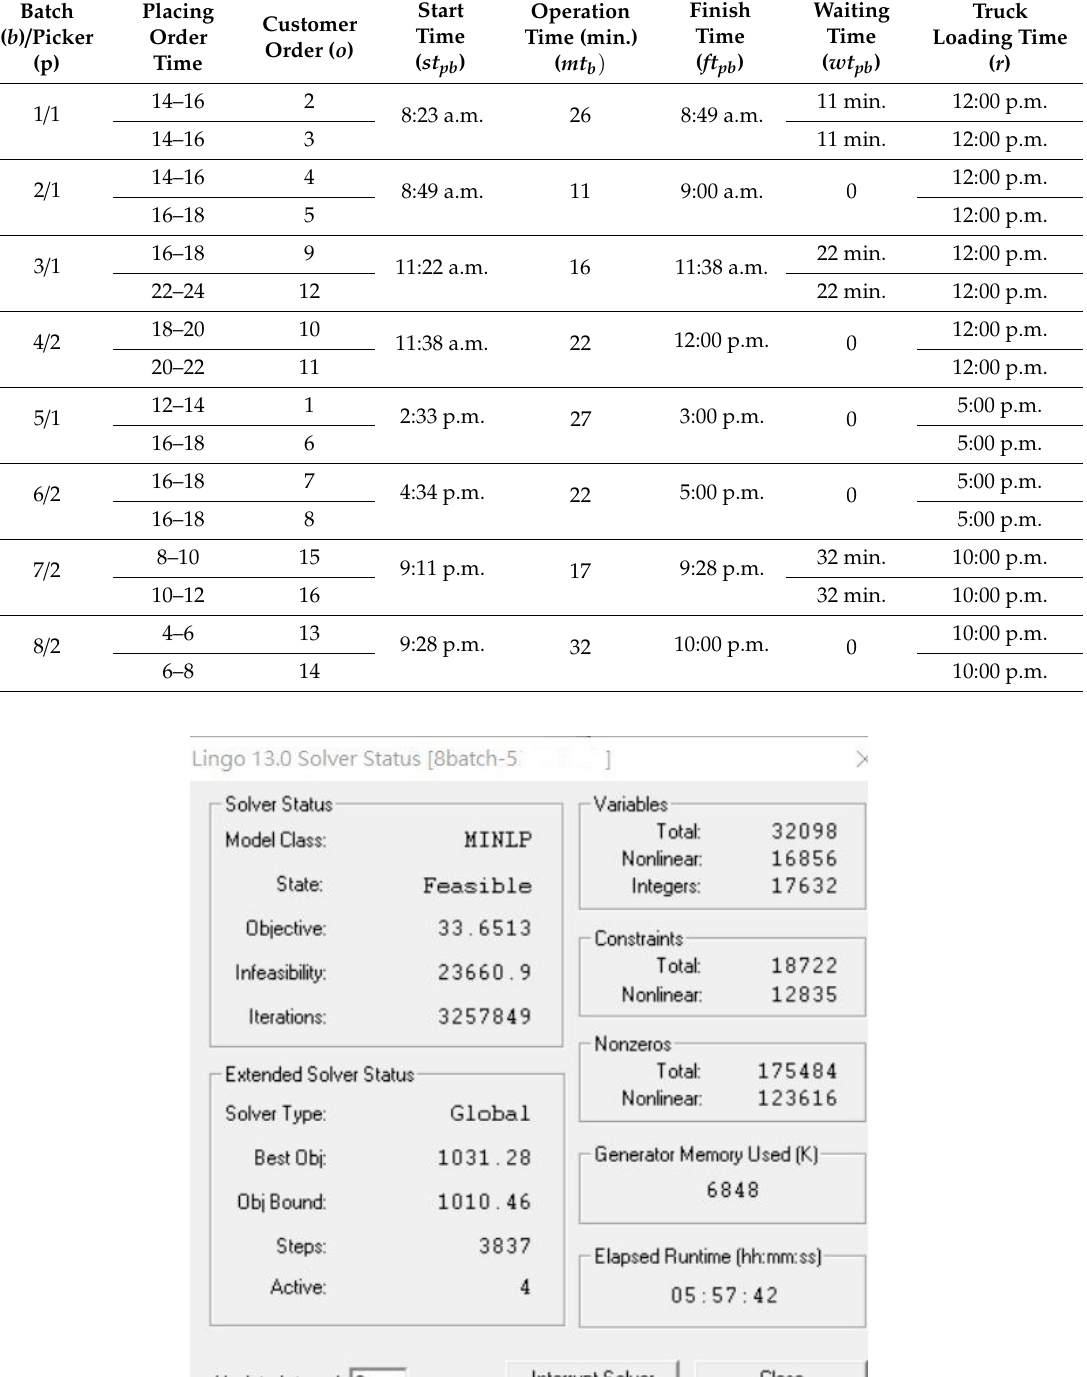
Table 9. The improvement results.